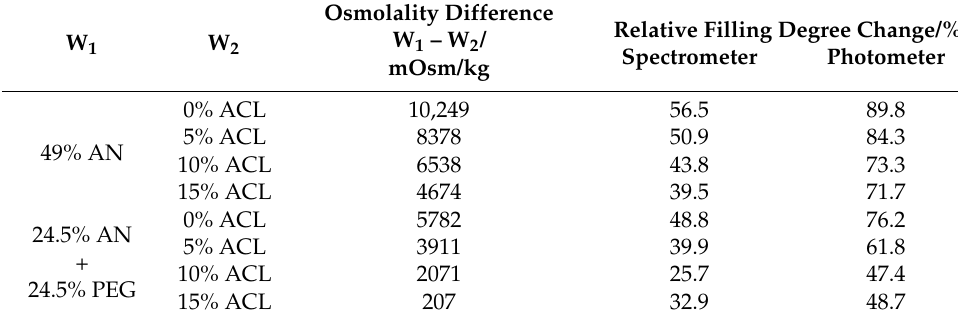
Table 2. Comparison of the osmolality difference and relative filling degree change for each inves- tigated double emulsion. AN: ammonium nitrate. ACL: ammonium chloride. PEG: Polyethylene glycol.